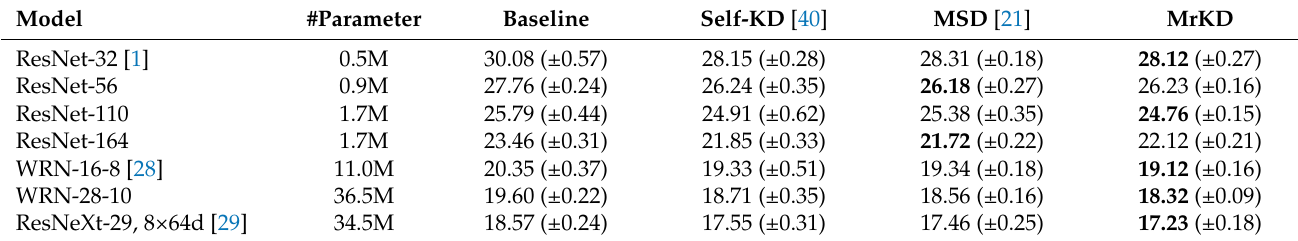
Table 2. Test error rate comparison on CIFAR-100 [26] dataset (mean( ± standard deviation), in